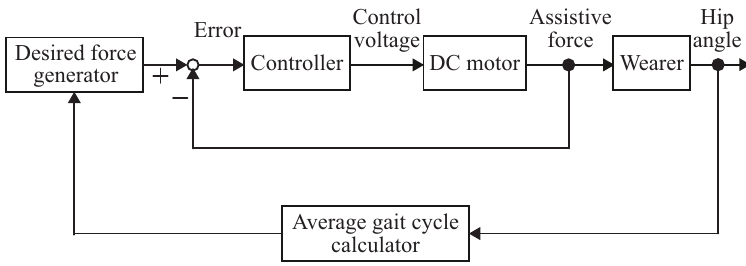
Figure 3. Control architecture of the robotic suit.